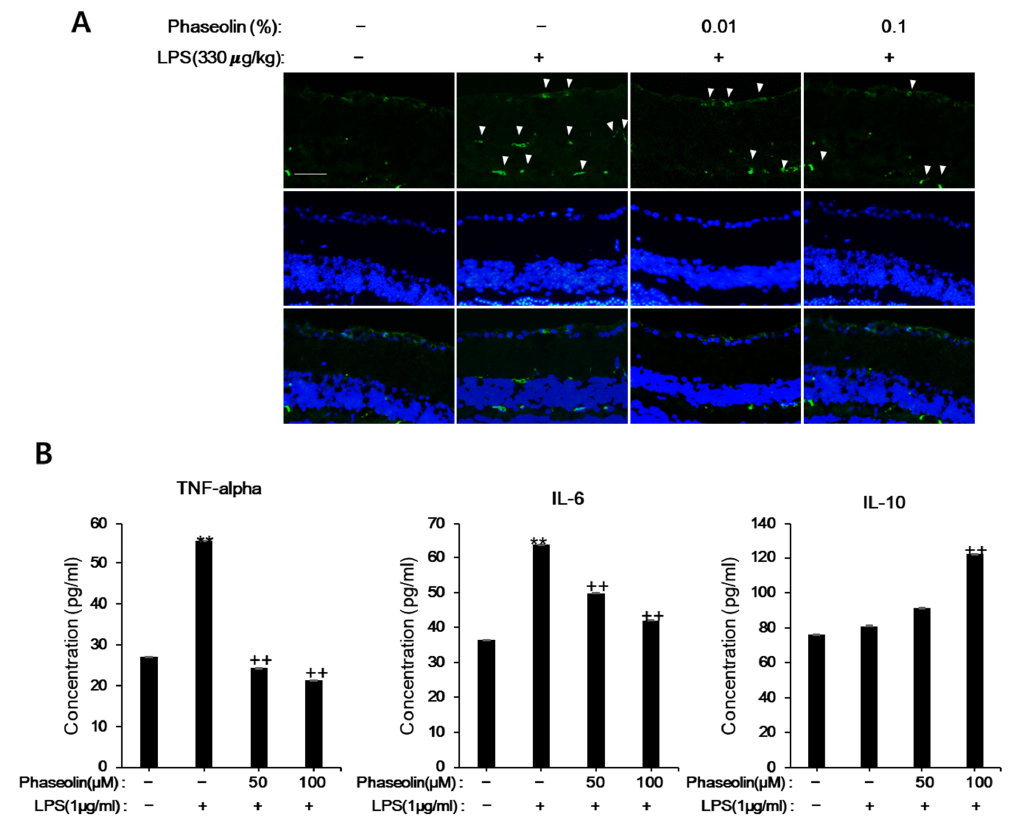
Figure 8. Effects of phaseolin on Ninj1 expression in LPS-induced uveitis mouse model. Mice were injected intraperitoneally (i.p.) with LPS (330 μ g/kg), followed by eye drops of either vehicle or 0.01% or 0.1% phaseolin twice a day for 3 days. Twenty-four hours after the last LPS treatment, the mice were sacrificed and enucleated eyes were subjected to immunofluorescent staining ( A ) and ELISA ( B ). In the immunofluorescence staining of Ninj1, the nuclei were stained with 1 μ g/mL DAPI (blue). ** p < 0.01, vehicle vs. LPS-treated group; ++ p < 0.01, LPS vs. LPS + phaseolin-treated group. A scale bar indicates 50 μ m.